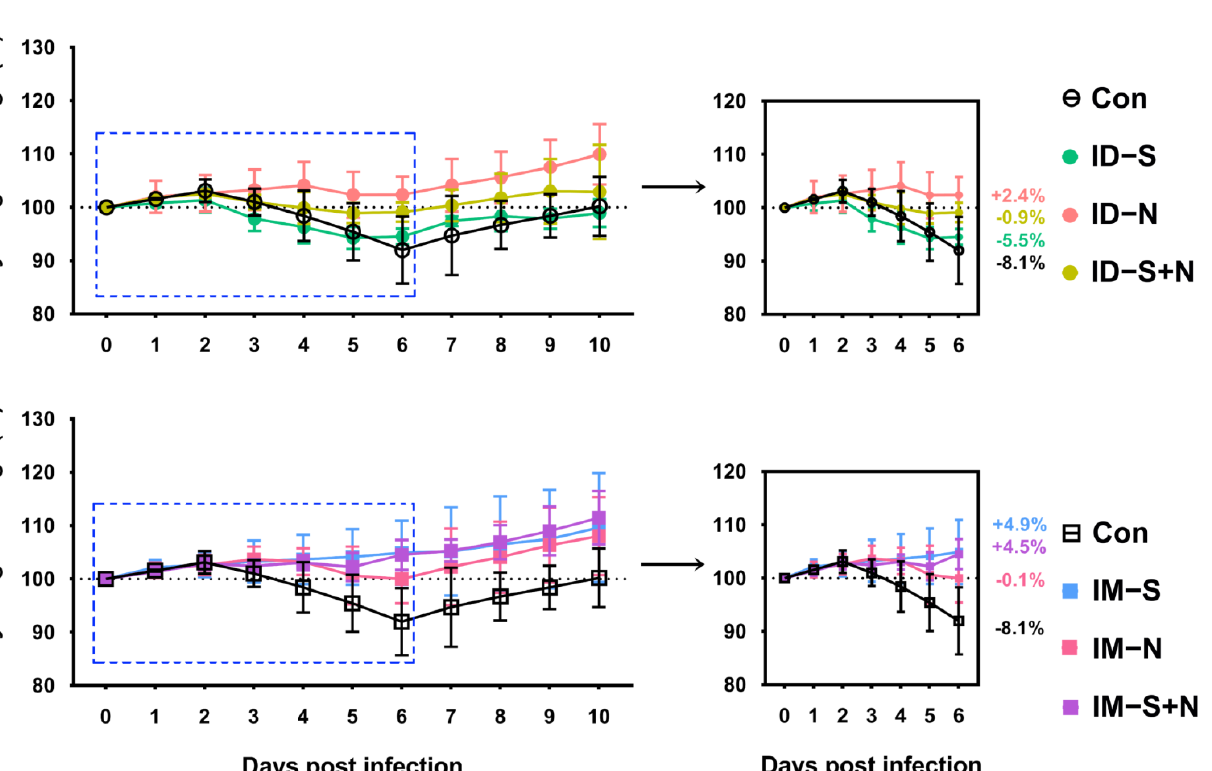
6 of 14 Figure 2. Levels of antibody production induced by experimental recombinant proteins after ID and IM immunization. The titers of neutralizing antibodies and IgG antibodies against S, N, and whole virus antigens (WVN) were detected 14 days after the primary and booster immunizations. The white background is 14 days after the first immunization (primary), and the gray background is 14 days after the second immunization (booster). IM-S: immunized with the S protein via the IM route; IM-N: immunized with the N protein via the IM route; IM-S + N: immunized with the S/N mixed protein via the IM route; ID-S: immunized with the S protein via the ID route; ID-N: immunized